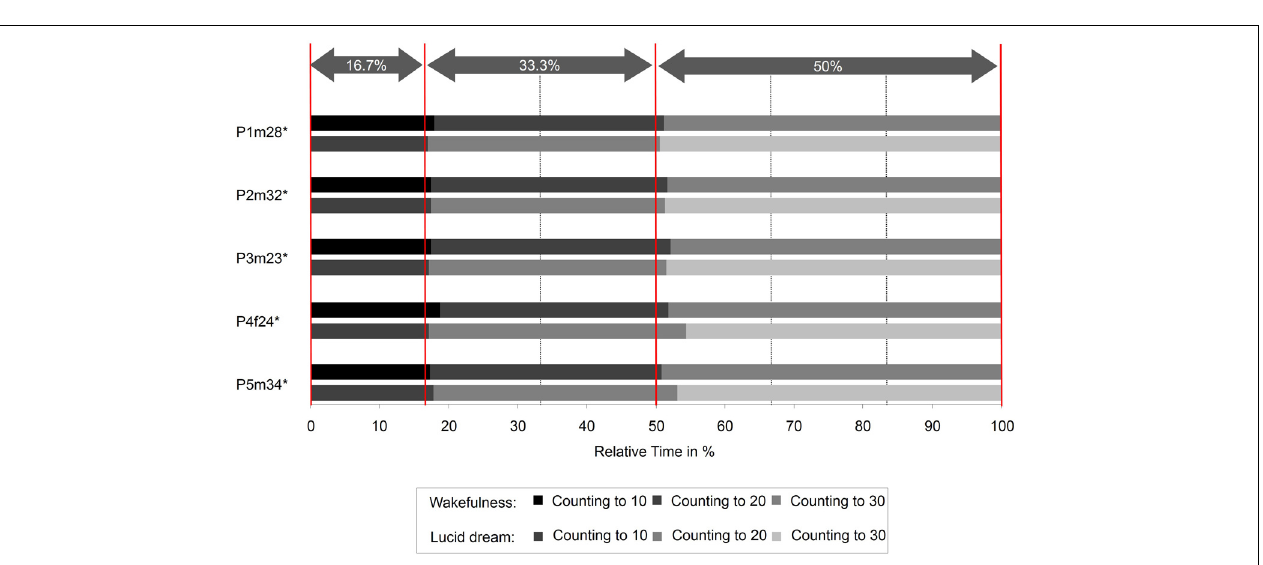
FIGURE 4 | Relative durations for the counting task during wakefulness and lucid dreaming (Labels: e.g., P1m28 = Participant 1, male, 28 years. ∗ Participants of the counting task also completed the walking task).